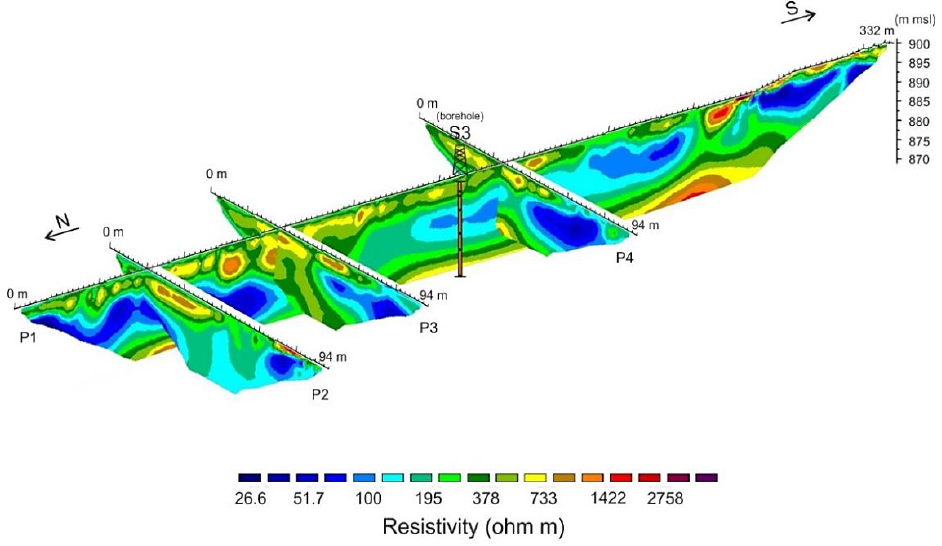
Figure 4. 3D view of inverted resistivity data on the Raibl tailings impoundment.